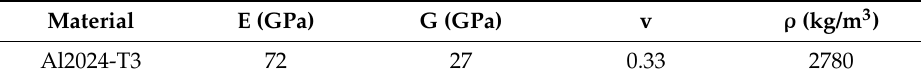
Table 1. Mechanical properties of 2024-T3 aluminum alloy